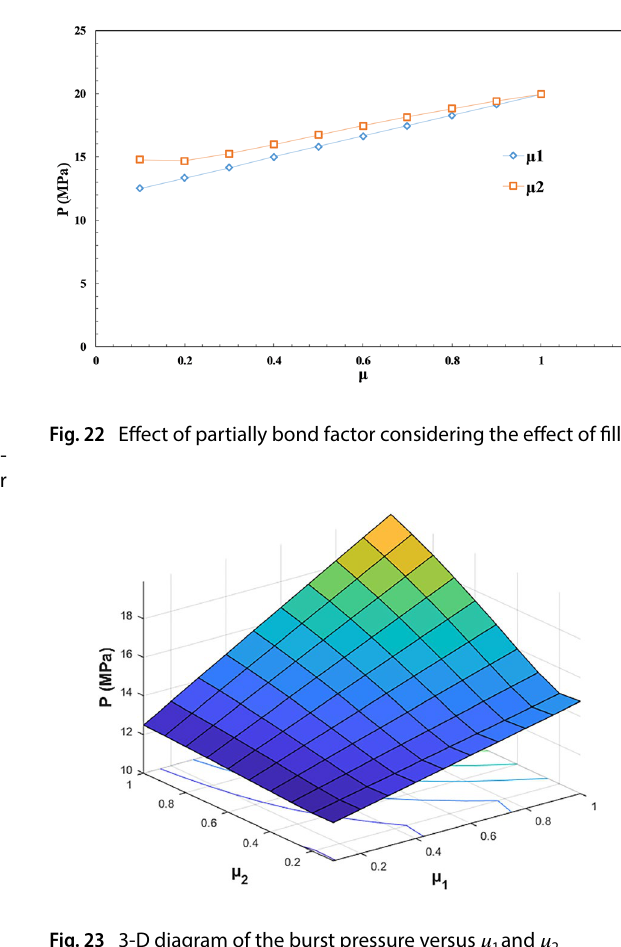
Fig. 21 Circumferential strain in the pipe, filler and sleeve at differ- ent elasticity modulus of the filler along radial centerline from inner layer of the pipe up to outer layer of the composite sleeve